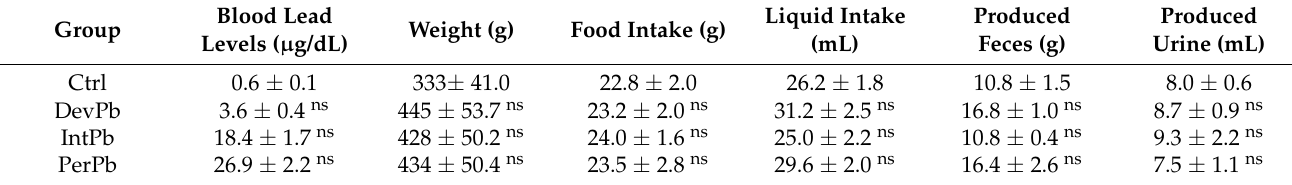
Table 1. Blood lead levels and metabolic parameters of lead-exposed groups. Values are the mean ± SEM. The asterisks denote statistically significant differences between groups; ns—not significant; one-way ANOVA, with multiple comparisons (Dunnett’s test); n = 6/group.